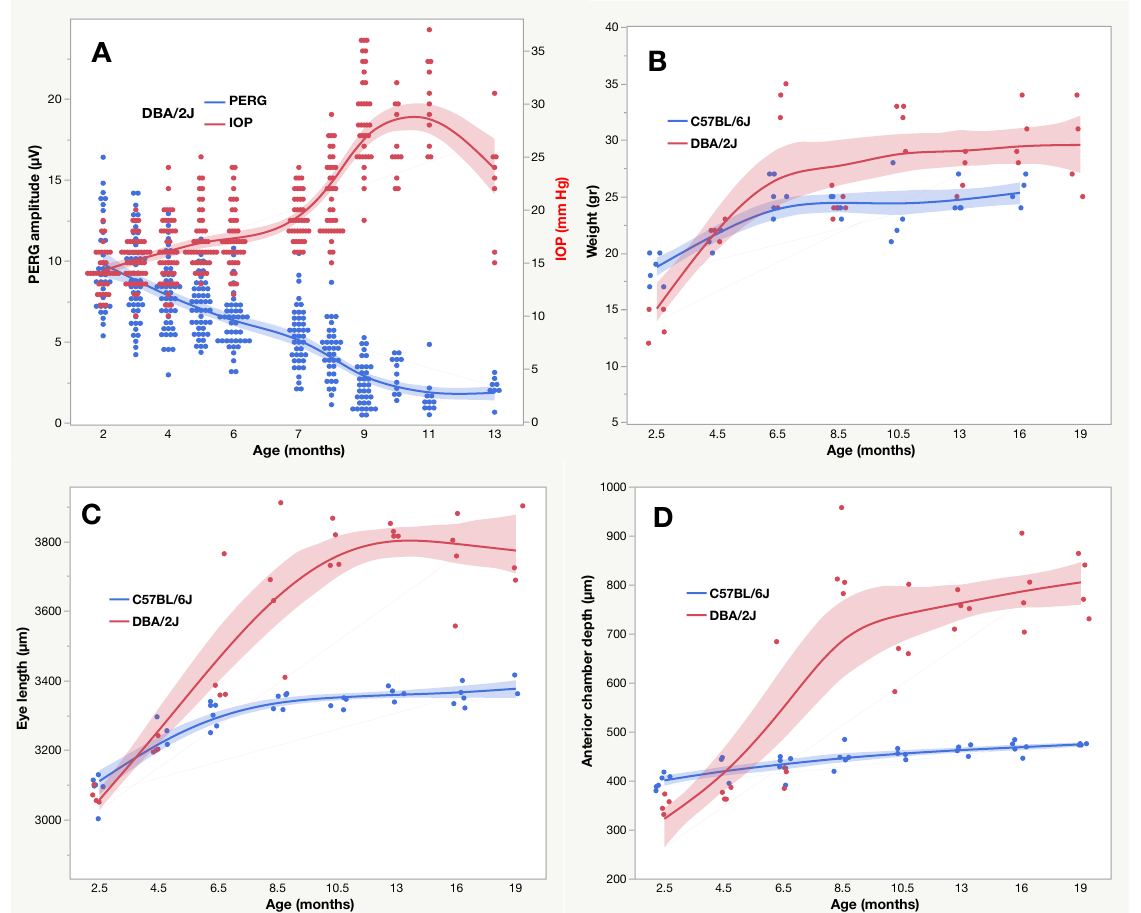
Figure 6. Age-related changes in C57BL/6J and DBA/2J mice. ( A ) PERG amplitude and IOP; ( B ) body weight; ( C ) Eye length; ( D ) anterior chamber depth. Panel ( A ) is replotted from Saleh et al., 2007 and panels ( B – D ) from Chou et al., 2010. The shaded areas represent the 95% confidence interval of the spline regression